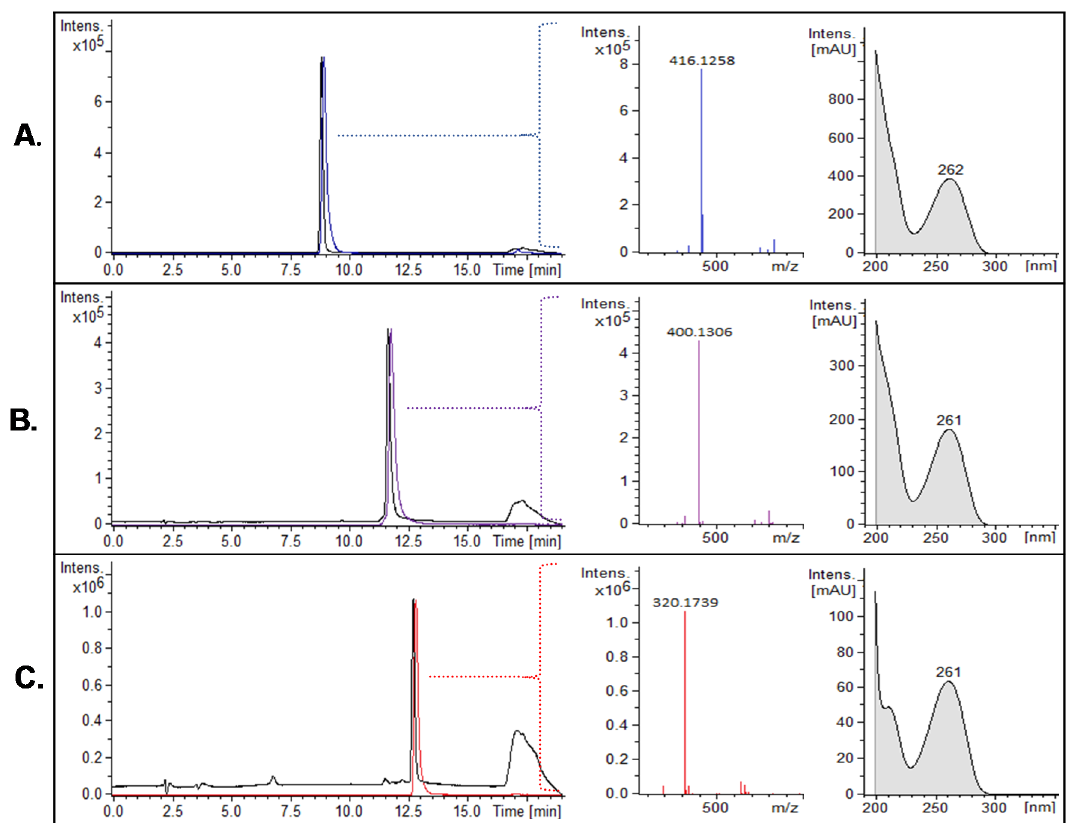
Figure 3. Purity assessment of three isolated CYNs: ( A ) CYN, ( B ) 7D-CYN and ( C ) 7D-desulfo-CYN. Every subfigure shows, in sequential order: overlapped EIC* (colored chromatogram) and EC** at λ 262 nm (black chromatogram), the protonated precursor’s m / z (colored mass spectrum) and the UV absorption spectrum. *EIC: extracted ion chromatogram (MS) of the protonated precursor ion. **EC: extracted chromatogram (UV). mAU: milli-absorbance unit.